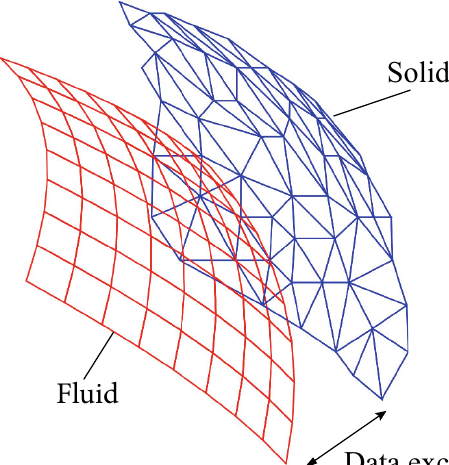
Figure 3: Data exchange between mismatched grids.